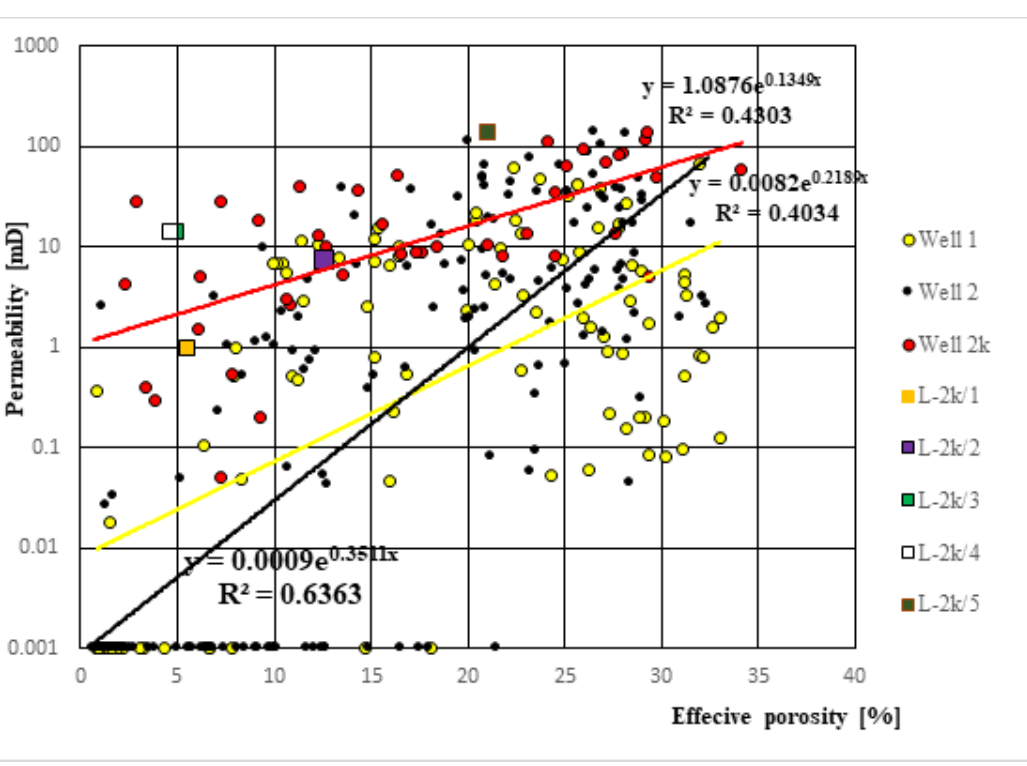
Figure 4. Relationship between e ff ective porosity and permeability ([24,25,90] and this work L